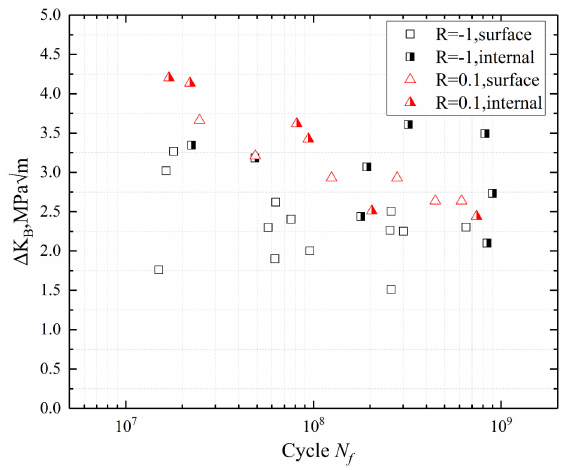
Figure 13. The ∆ K B vs. the fatigue life.